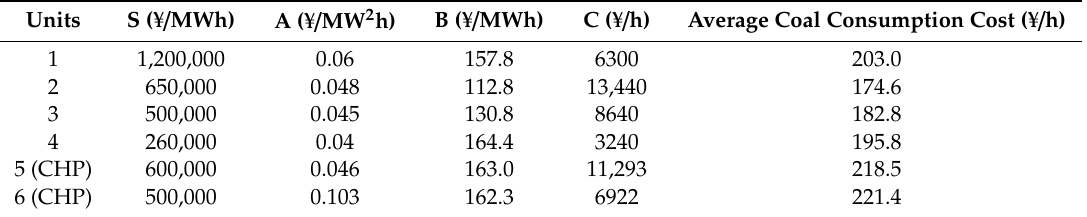
Table 3. The operation cost coe ffi cient of the thermal power units.